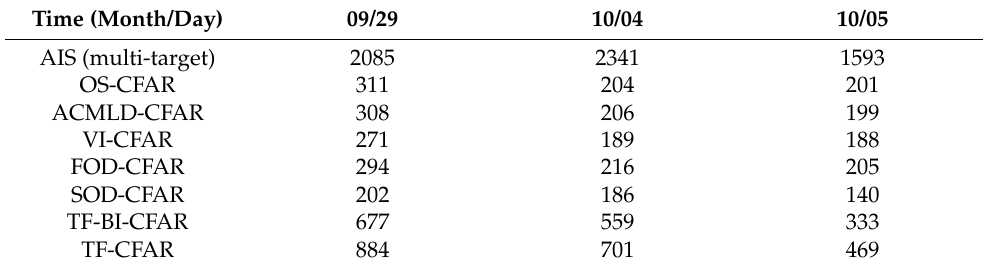
Table 6. The number of matched multi-target pairs such as Target 6 and Target